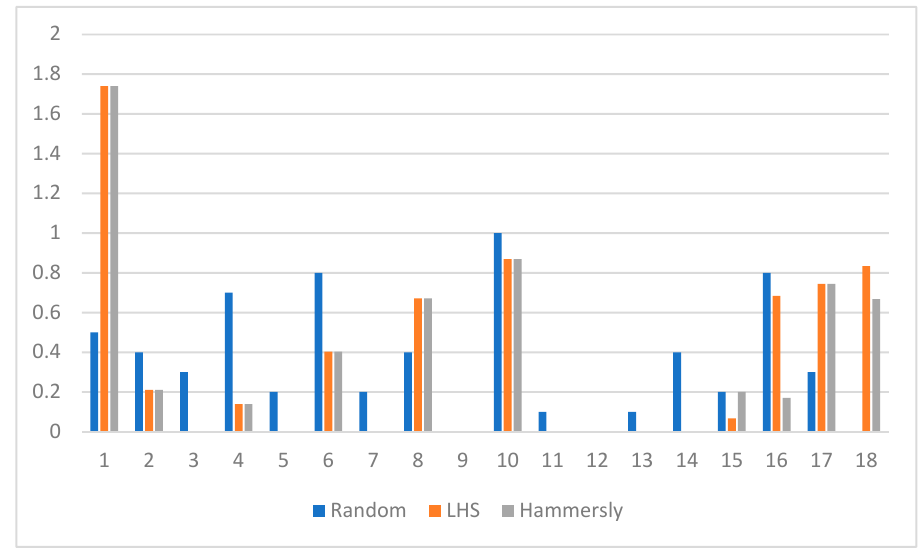
Figure 4. The di ff erences in max. Absolute error and the standard deviation for Figure 4. The differences in max. Absolute error and the standard deviation for sampling.